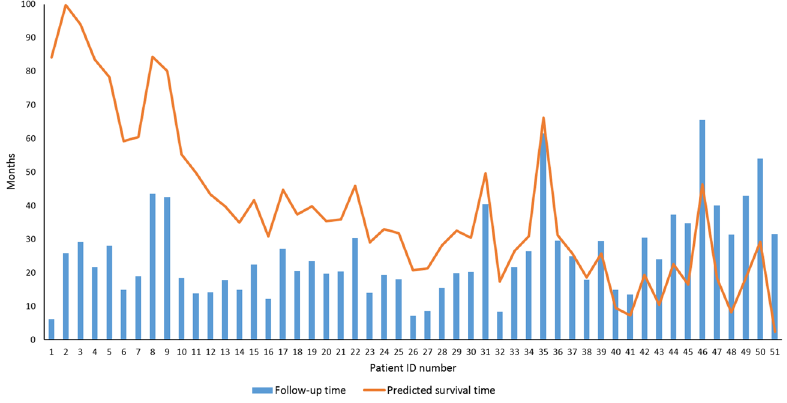
Figure 2. The validation of SVR-LUAD on an independent cohort of 51 patients with lung adenocarcinoma. Predicted survival time is larger than the follow-up time for the first 38 patients